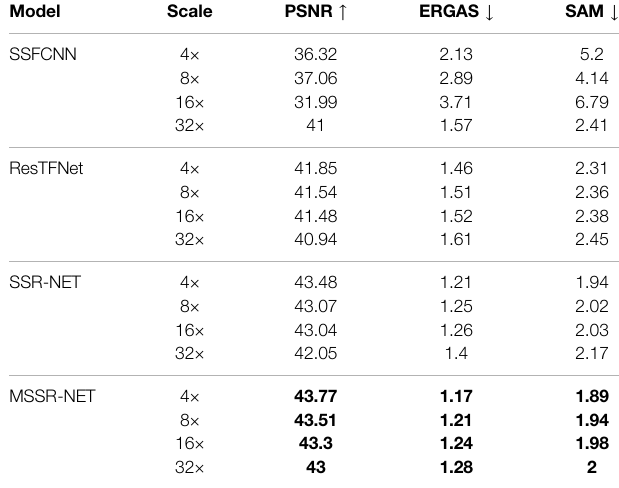
TABLE 3 | Quantitative results on Pavia University dataset. HR MSI is generated according to Type 1 model by taking fi ve spectral bands. Model